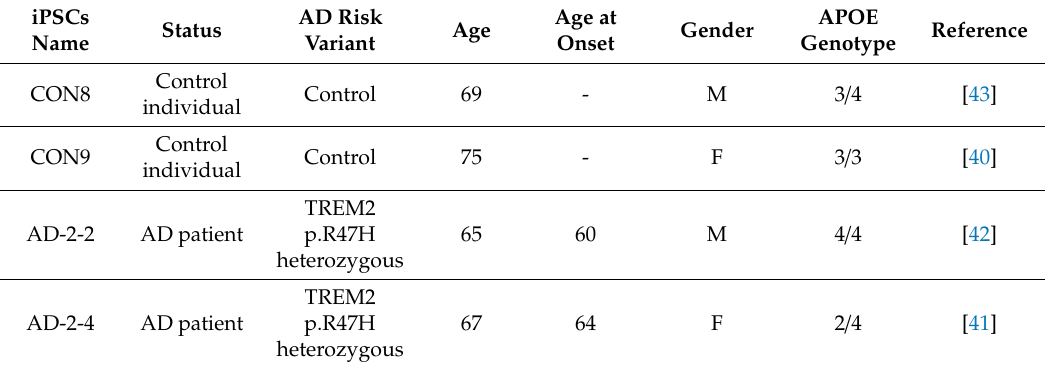
Table 1. Summary of the healthy controls and Alzheimer’s disease (AD) induced pluripotent stem cell (iPSC) lines used in this